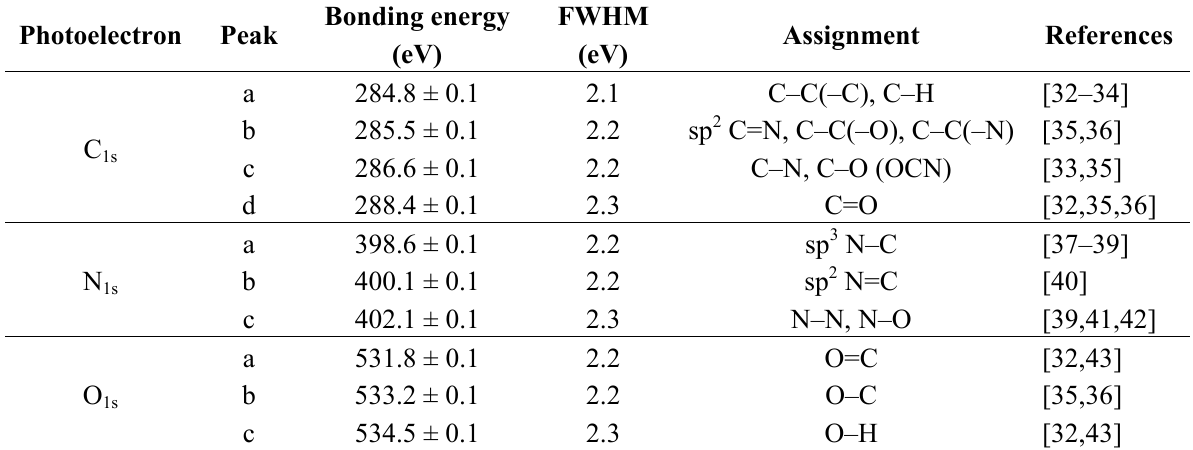
Table 1. Assignment of the XPS photoelectron peak decomposition for C O 1s